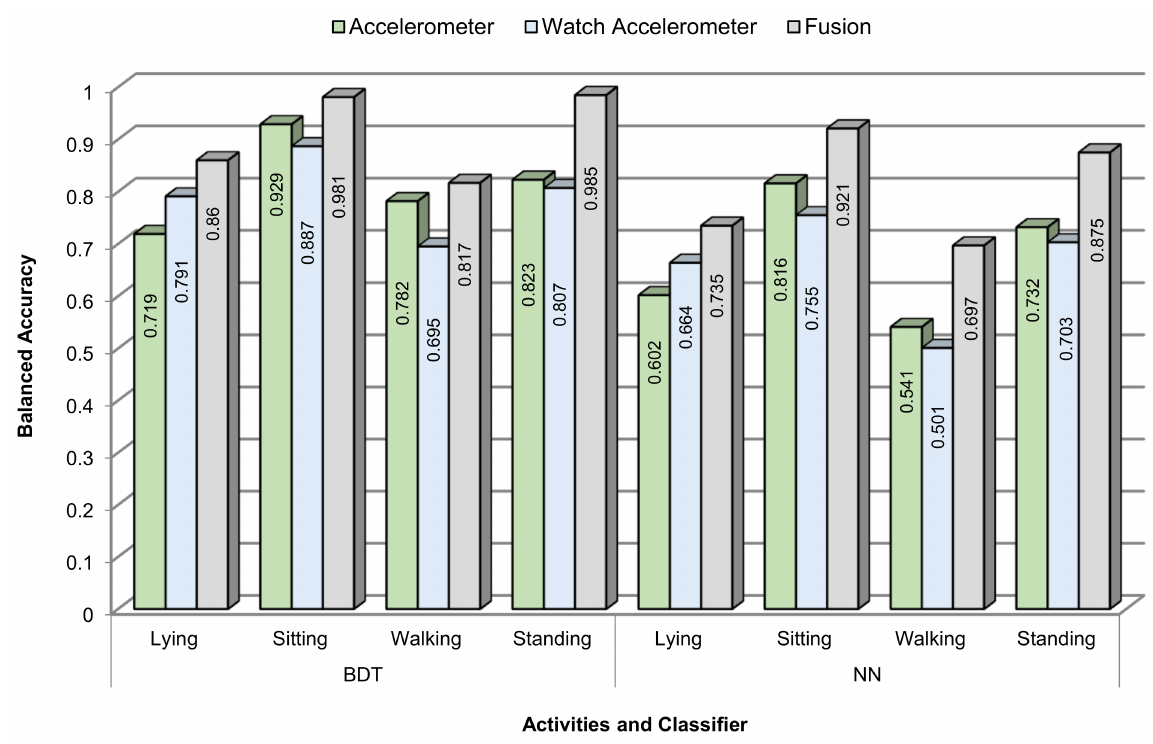
Figure 4. Average balanced accuracies achieved for BCR based on lying , sitting , walking , and standing activities using BDT and NN